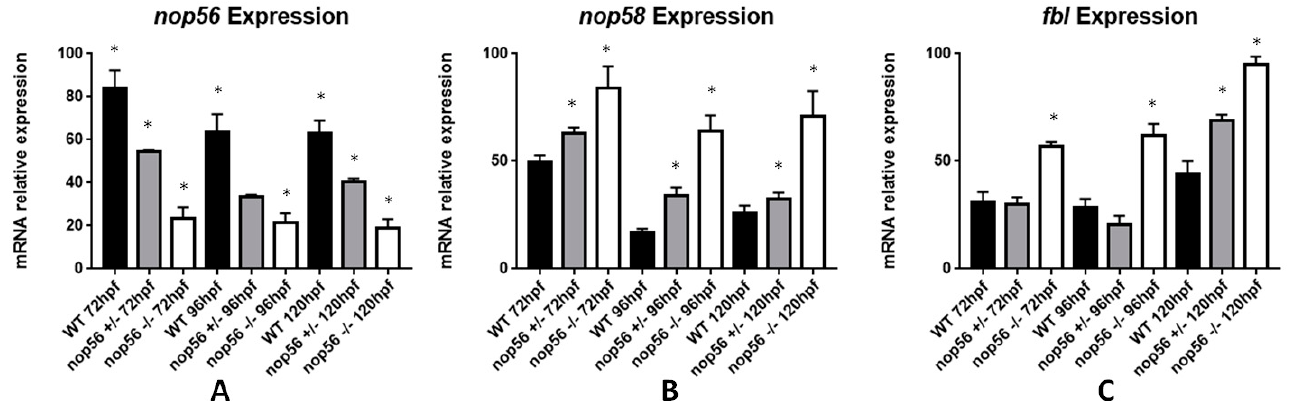
15 of 22 Figure 11. Graphic representation of expression analysis by RT-qPCR. ( A ) Zpld1a expression is significantly reduced in nop56 − / − larvae between 72 and 120 hpf ( p -value < 0.0001). ( B ) Zpld1a ex- pression is significantly reduced in nop56 − / − larvae between 72 and 120 hpf ( p -value < 0.0001) and in nop56 +/ − at 120 hpf. Statistically significant data in the graphs are indicated with a *. 3.7. nop56 Disruption Causes Overexpression in nop58 and fbl Related Genes and Impaired rRNA Processing NOP56 is a protein required for the assembly of the 60S ribosomal subunit. Together with NOP58 and FBL, they function as core proteins to form the C/D box small nucleolar ribonucleoprotein that modifies and processes ribosomal RNAs (see introduction). For this reason, we examined the mRNA expression of nop56 gene and associated genes nop58 and fbl by RT-qPCR (Figure 12). We observed significant differences in nop56 ex-